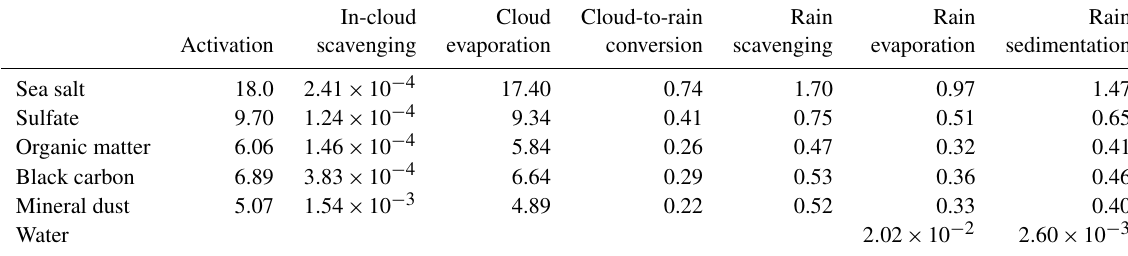
Table 4. Same as Table 3 but for the PN